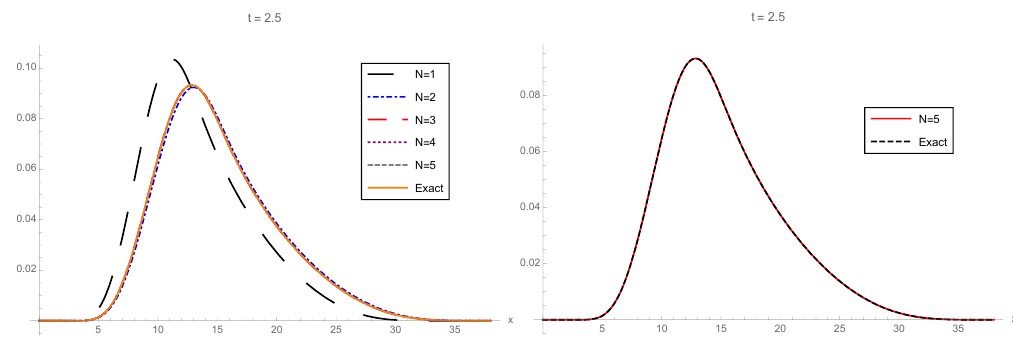
( x , t ) , of the truncated solution SP, X N ( t ) , to the random IVP (34) taking as Figure 6. Left: 1-PDF, f N 1 the order of truncation N ∈ { 1,2,3,4,5 } and the corresponding 1-PDF, f 1 ( x , t ) , of the exact solution SP ( x ,2.5 ) , with N = 5, is plotted together with f at t = 2.5. Right: To facilitate the comparison, f N 1 Example 2.